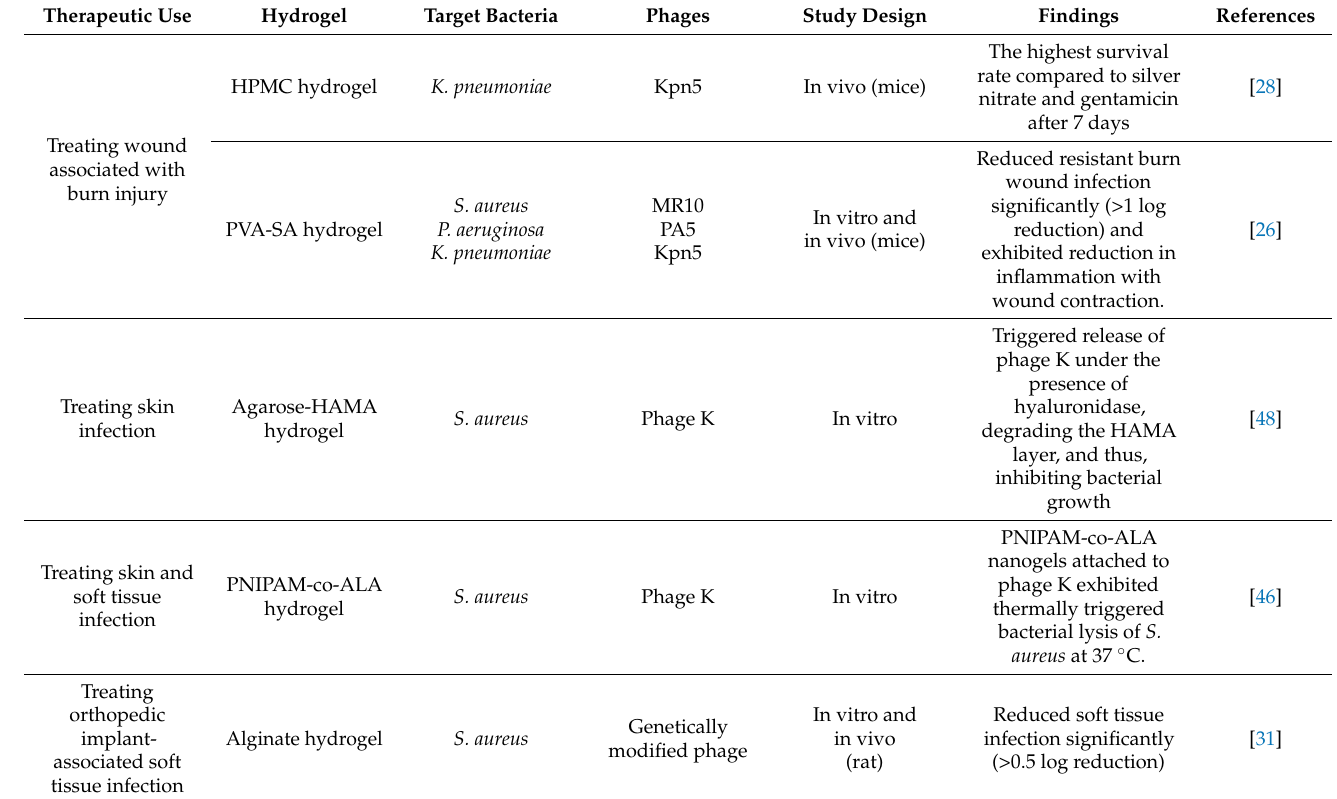
(Table 4) [46]. In another study, treatment with PVA-SA hydrogel-based membrane contain- ing phages MR10, Kpn5 and PA5 (all at a reported MOI of 10) resulted in 6 log reduction in S. aureus , 6.37 log reduction in Klebsiella pneumoniae and 4.6 log reduction in P. aeruginosa biomass, respectively, after 6 h in vitro (Table 4) [26]. Treatment with MR10 hydrogel resulted in fast wound healing in S. aureus burn wound infection model in mice as com- pared with non-treated control, particularly when minocycline was used in combination. On day 14, those receiving dual-agent treatment showed complete regeneration of skin layers, sweat glands and hair follicles similar to normal mouse skin. In addition to rapid wound healing, phage hydrogels significantly reduced mortality in mice burn wound infection model [28]. A study by Kumari et al. demonstrated that treatment with phage Kpn5 in HPMC hydrogel (MOI of 200) increased the survival rate of Klebisella -infected animals as compared with other antimicrobials, including silver nitrate and gentamicin (Table 4). All mice in the phage hydrogel treated group survived, while 87% survived in the non-treated group on day 1. On day 7, the phage-treated group showed the highest level of protection (63%) as compared with the untreated group (0%). The survival rate may be further increased by the combined use of phages and antibiotics. Table 4. Summary of phage-delivering hydrogels in trauma-associated skin and soft tissue infection. Therapeutic